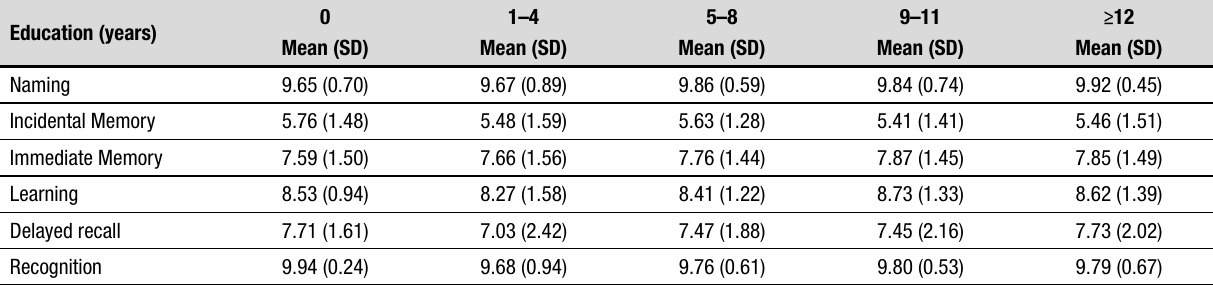
Table 3. Figure Memory Test according to attained years of